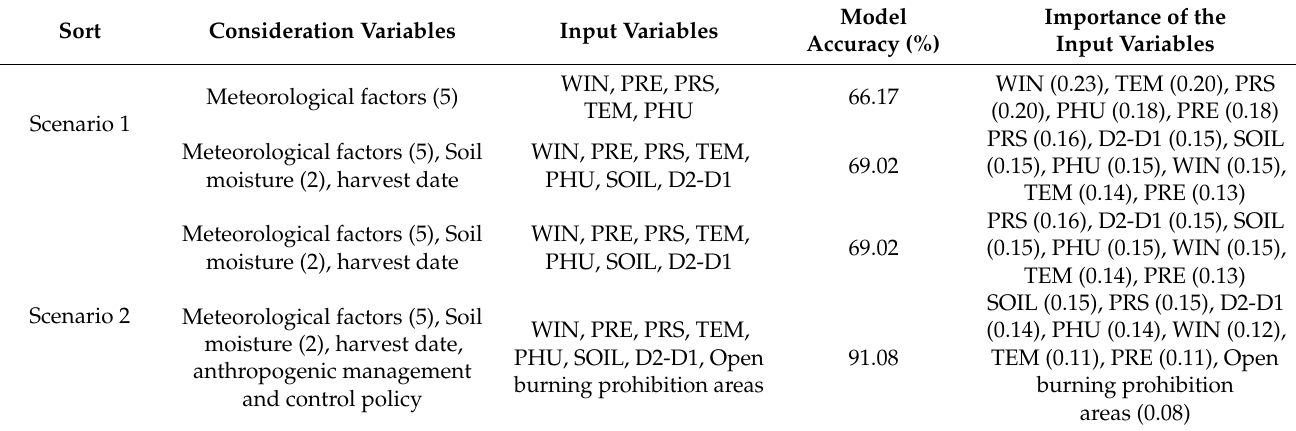
Table 6. Importance between input variables and field burning fire point forecasting results for the different models developed in this study. The importance of the input variables was sorted from high to low. The value in parentheses after the variable means the importance score calculated by the SPSS Modeler 14.1